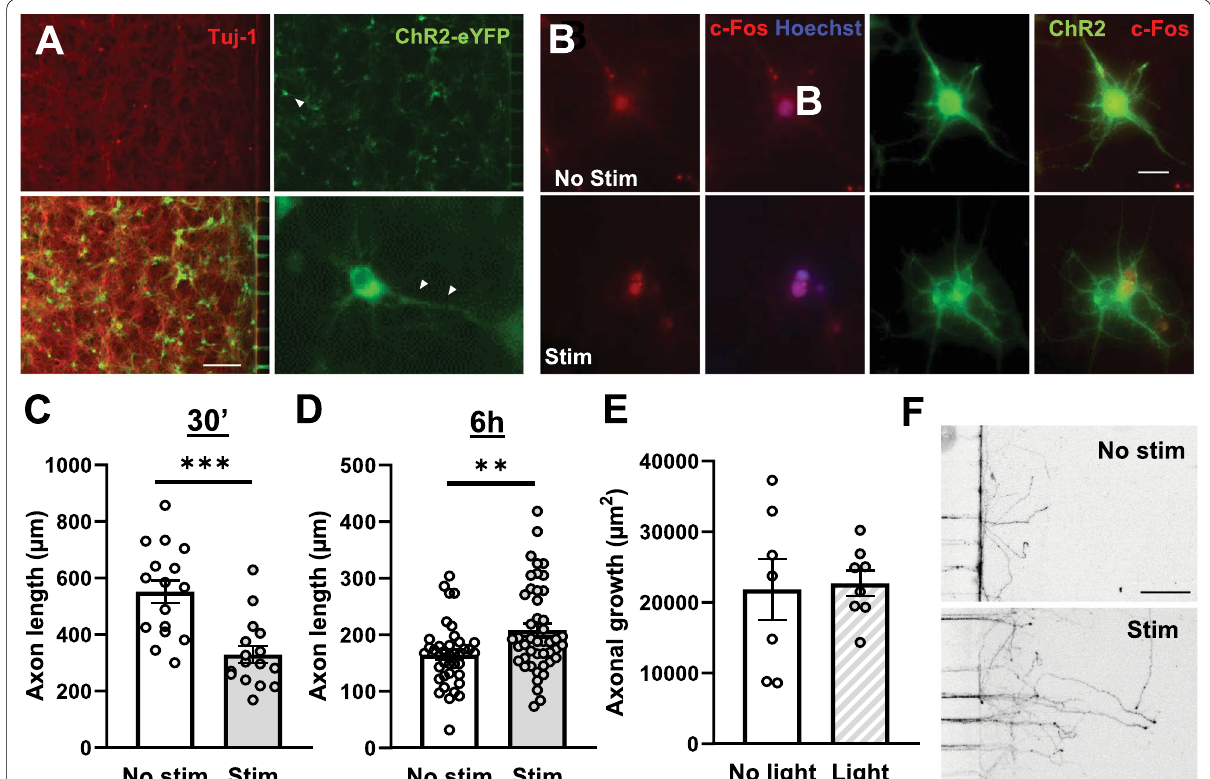
Fig. 4 Optogenetic stimulation of cortical neurons after axotomy. A Cortical neurons (Tuj‑1) express ChR2‑eYFP after LV‑ChR2 infection. White arrows in the high magnification image indicate neuritic expression of ChR2. Scale bar: 250 μm. B Optogenetic stimulation increased the expression of c‑Fos in cortical neurons. Representative images of c‑Fos (red) and ChR2 (green) immunostaining. Scale bar: 20 μm. C , D Optogenetic stimulation of cortical neurons 30 min after axotomy ( C ) resulted in reduced axon regeneration, while delivering the stimulation 6 h after axotomy ( D ) increased axon regeneration. Individual ChR2 + axon lengths were quantified ( C : n 16 images; D : n 37–43 images). Data are expressed as mean s.e.m. = = ± ***p < 0.001 denotes significant differences in Student’s t‑Test; **p < 0.01 denotes significant differences in Mann Whitney test. E Optical stimulation (470 nm light) of GFP‑expressing cortical neurons did not induce any changes in axonal regeneration. Total growth area/microchannel was computed (n 7–8 images). Data are expressed as mean s.e.m. F Representative images of GFP/YFP staining used to analyze axon regeneration = ± when stimulation is applied 6 h after axotomy. Scale bar: 200